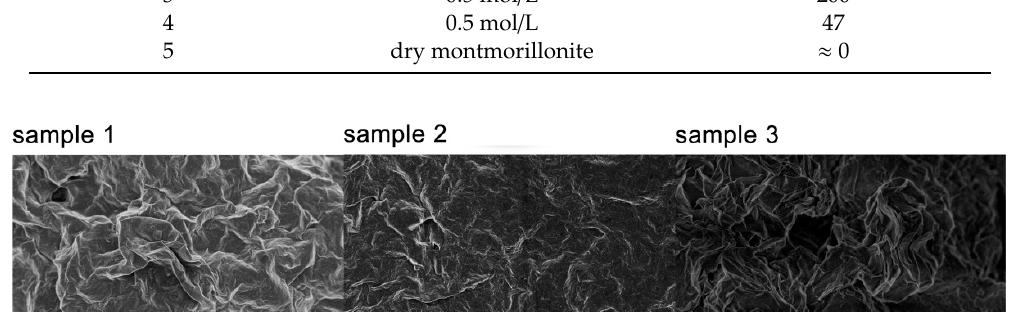
Table 3. Lattice constants of XRD samples. Number